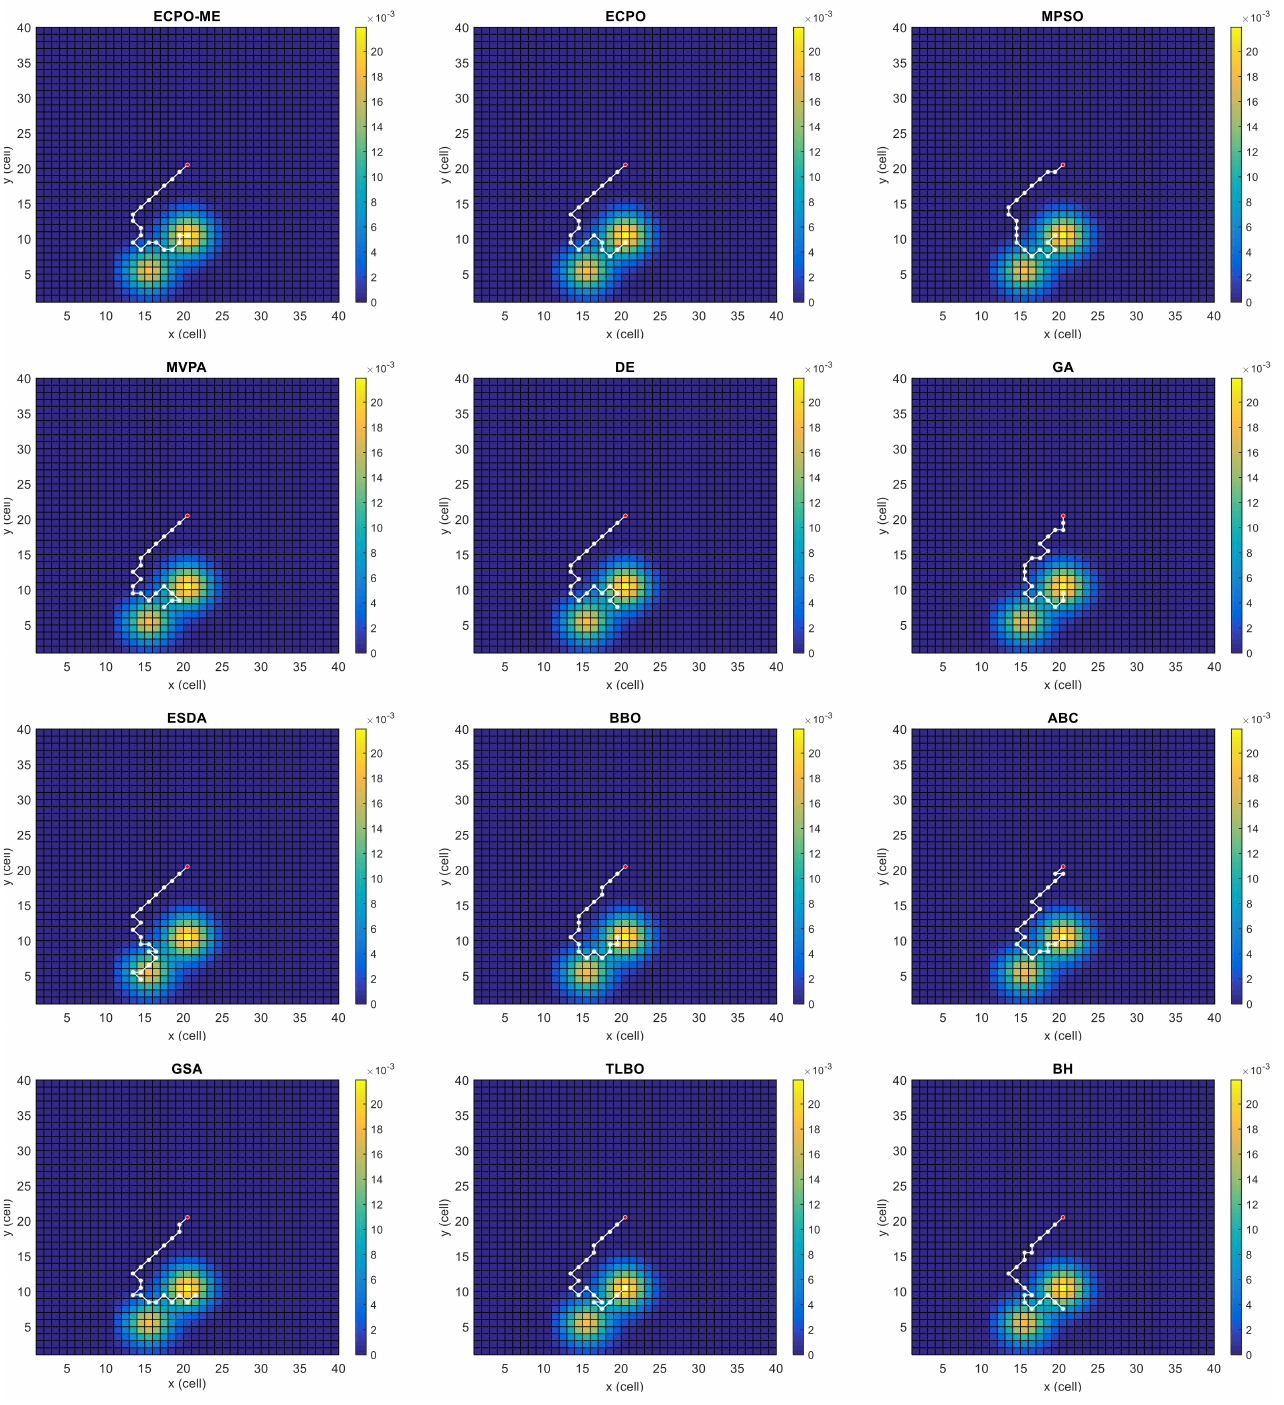
Figure 4. Search paths for Scenario A, obtained using the tested